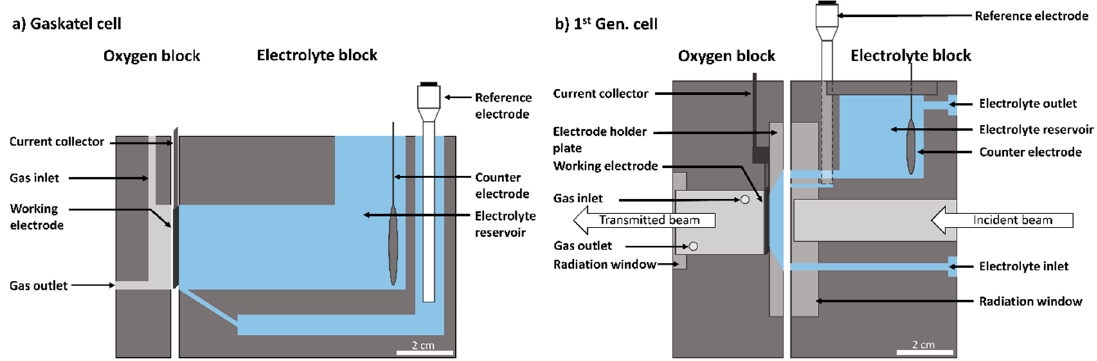
Figure 2. Schematic diagram of ( a ) Gaskatel cell and ( b ) first generation (1 st Gen.) cell with relevant parts. Figure2. Schematicdiagramof( a )Gaskatelcelland( b )firstgeneration(1 st Gen.)